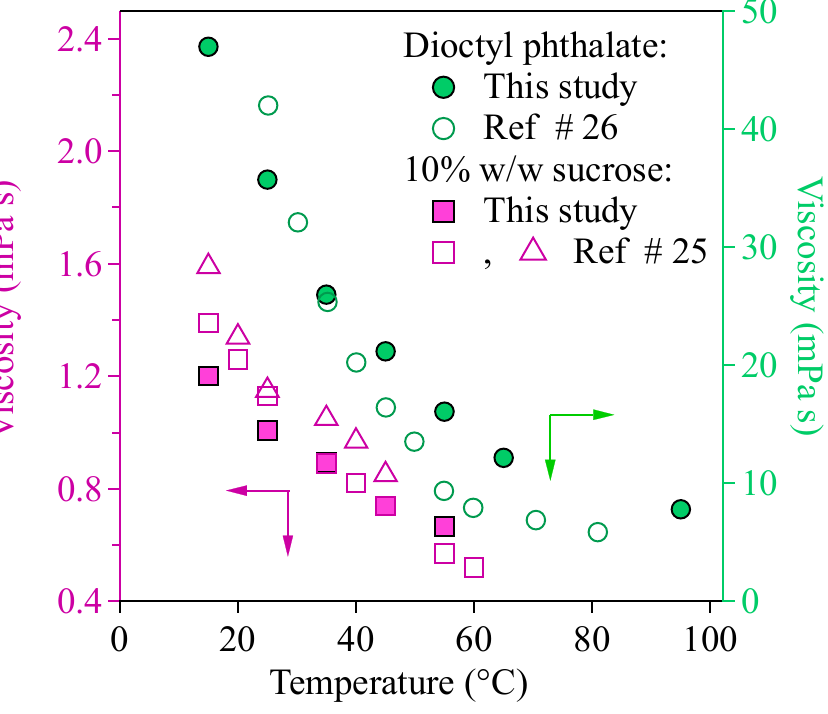
Figure 5. Comparison among the temperature-dependent viscosity of this study and those of other reports in the literature for the 10% w / w sucrose [26] and dioctyl phthalate [27]. As the temperature increased, kinetic motion increased, which enhanced the breaking of intermolecular bonds between adjacent layers, thus reducing the viscosity [28]. The decreases in the viscosity as temperature increases follows the Arrhenius equation [29,30]: